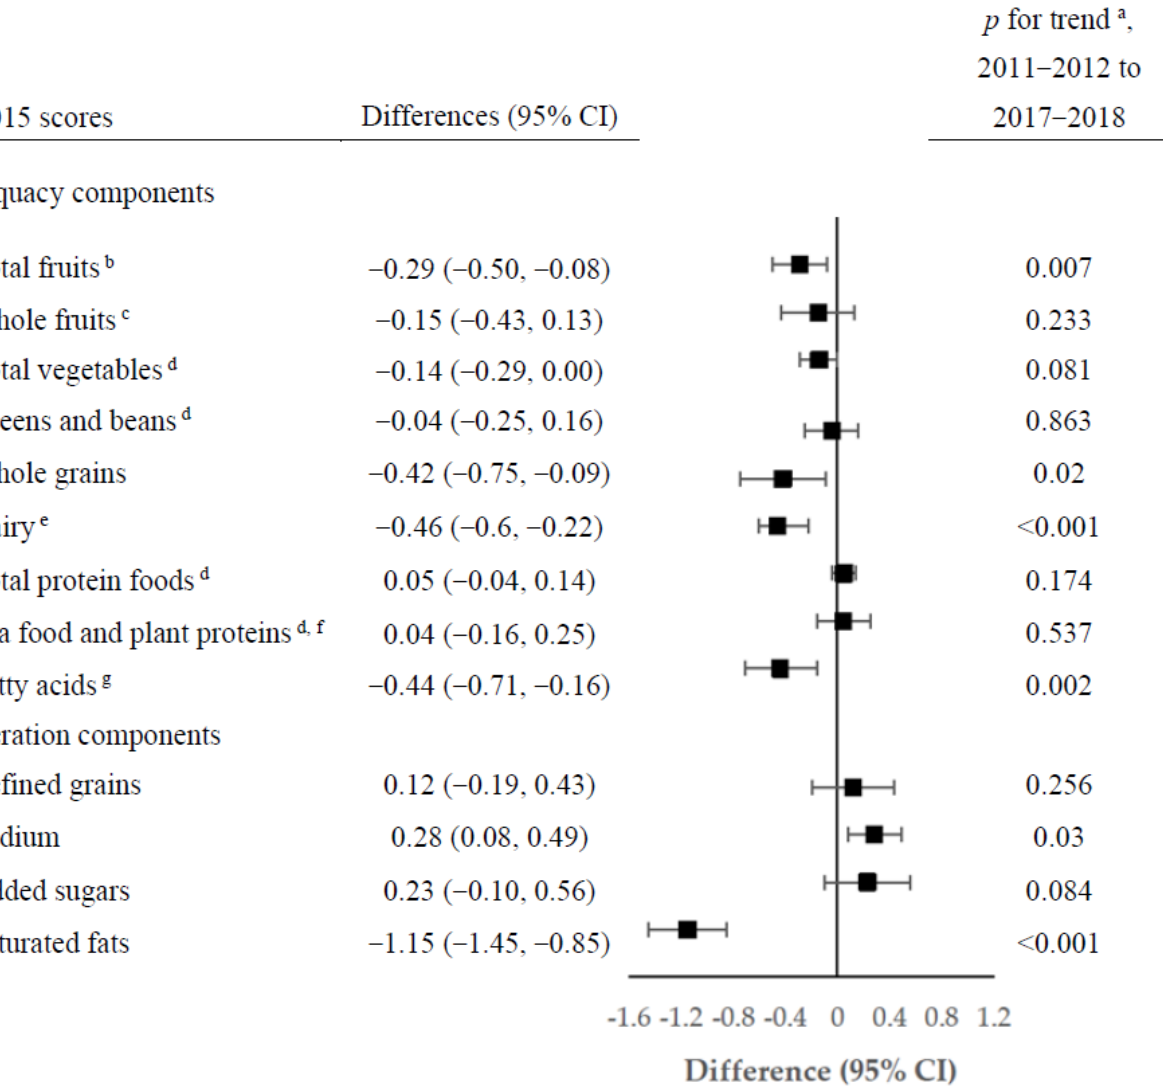
Figure 1. Changes in estimated scores of HEI-2015 components among US adults aged ≥ 20 years by NHANES cycles from 2011 – 2012 to 2017 – 2018. a p value from trend tests by modeling survey period as a continuous variable. b Includes 100% fruit juice. c Includes all forms except juice. d Includes legumes (beans and peas). e Includes all milk products, such as fluid milk, yogurt, and cheese, and legumes (beans and peas). g Ratio of PUFAs and MUFAs to SFAs ((PUFAs +